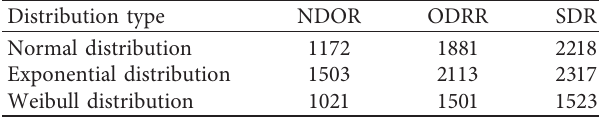
Table 5: Comparison of sales volume between SDR and other strategies under different distribution types.